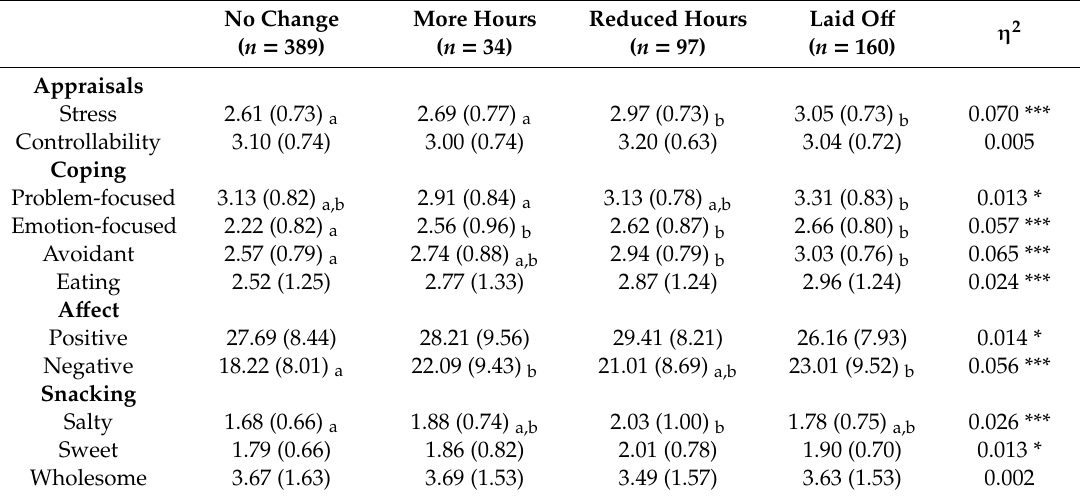
Table 3. Means (SD) of model variables as a function of change of employment